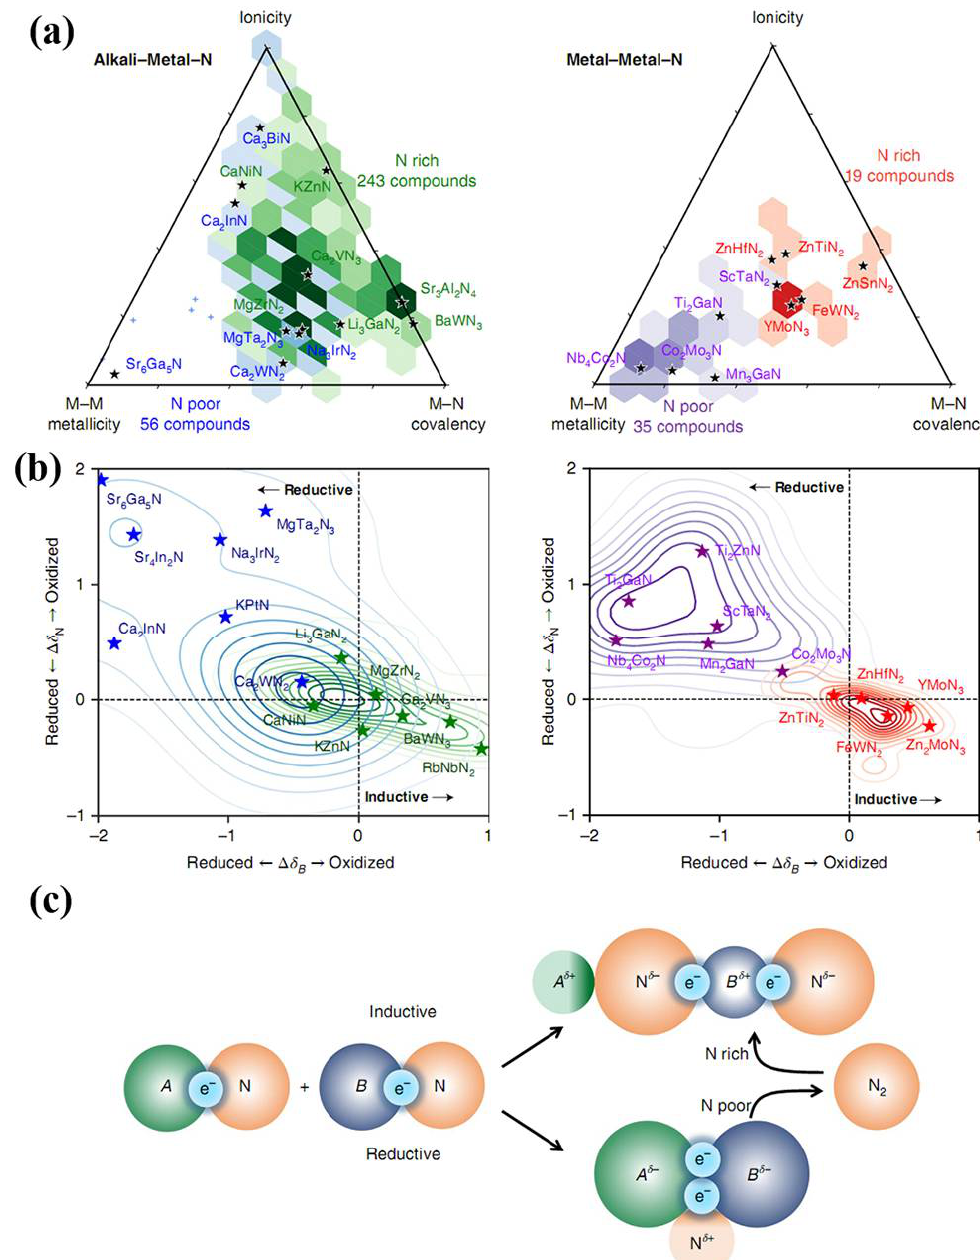
Figure 14. Electronic structure origins of ternary nitride stability. ( a ) Metallicity, ionicity, and covalency of the stable ternary nitrides, hexagonally binned on van Arkel triangles by the nitrogen excess or nitrogen deficiency of the ternary, compositionally referenced against the deepest-hull binary nitrides. Hexagons are plotted for regions with more than two data points only; outliers are shown with small crosses. The color intensity corresponds to the number density in each hexagon. Full van Arkel scatter plots can be found in Supplementary Section 8. ( b ) Kernel density distributions of ion oxidation and reduction between the deepest-hull binary nitrides and the stable ternary nitride, as determined from the DFT-computed charge density, for the nitrogen anion (vertical axis) and the more electronegative metal, B (horizontal axis). ( c ) Inductive effect: electropositive metal A donates electron density to the B–N.covalent bond, oxidizing the more electronegative metal, which can lead to nitrogen-rich nitrides. Reductive effect: nitrogen oxidation or nitrogen release provides electrons to Me–Me bonds, reducing the metals and increasing metallicity. Reprinted with permission from Sun et al., Nature Materials 18 , 732-739 (2019). Copyright 2019 Nature Publishing Group (Ref. 88).